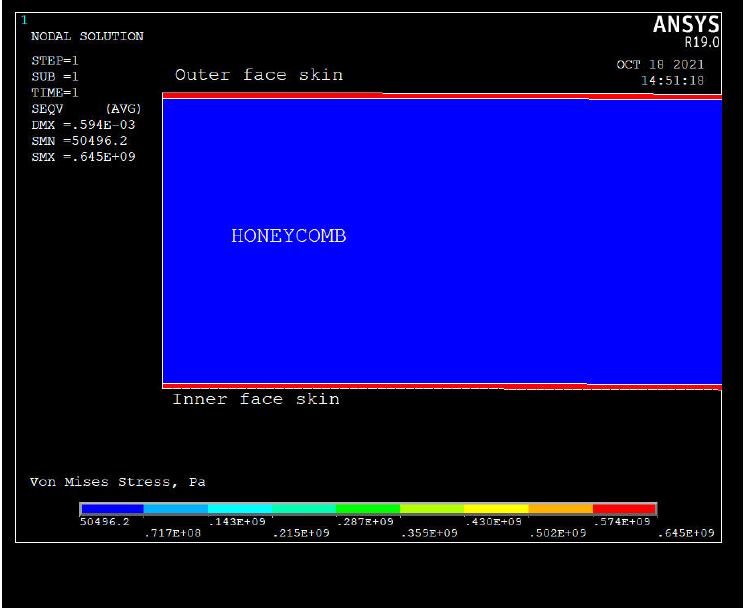
Figure 6. Von Mises stress in the structure (fragment) from the FEA analysis (buckling safety factor of 2.65 and payload fraction of 0.1). The maximum stress in the face skins does not exceed 645 MPa, and the stress in the honeycomb is comparable to the atmospheric pressure.